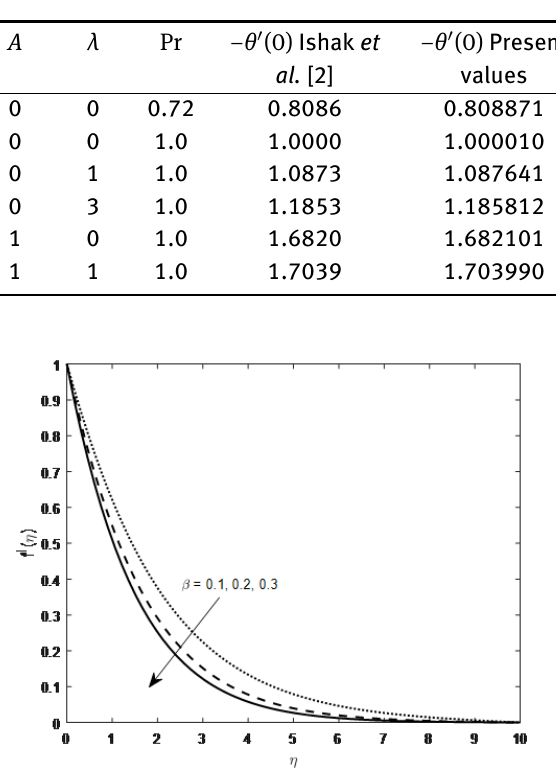
Table 2: Comparison of the values of ( − θ ′ (0) ) with the previous work